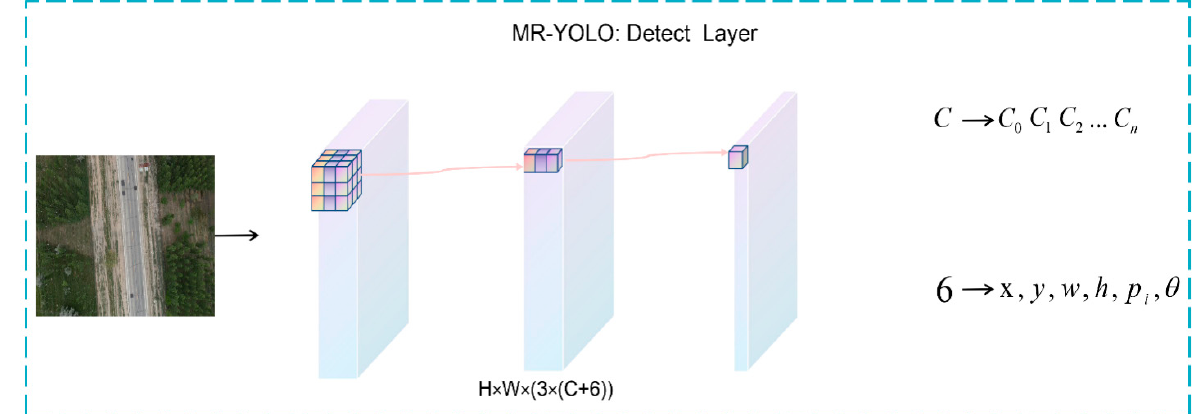
Figure 8. MR-YOLO: Head Detail Inspection